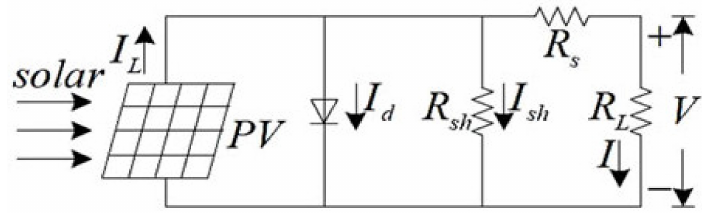
Figure 7. The equivalent circuit of the solar